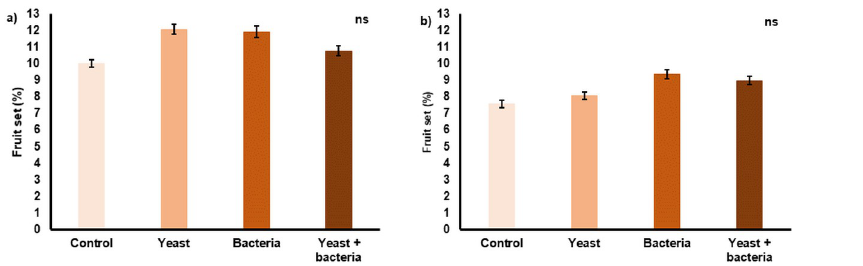
Fig 4. Average fruit set (%) per tree (N = 60) for each inoculation treatment applied in 2019 (a) and 2020 (b). Treatments included inoculation of flowers with Metschnikowia reukaufii (yeast), Acinetobacter nectaris (bacteria), and a combination of both (yeast + bacteria). As a control, flowers were sprayed with water. There were no significant (P > 0.05) differences among treatments (ns). Error bars represent standard errors of the